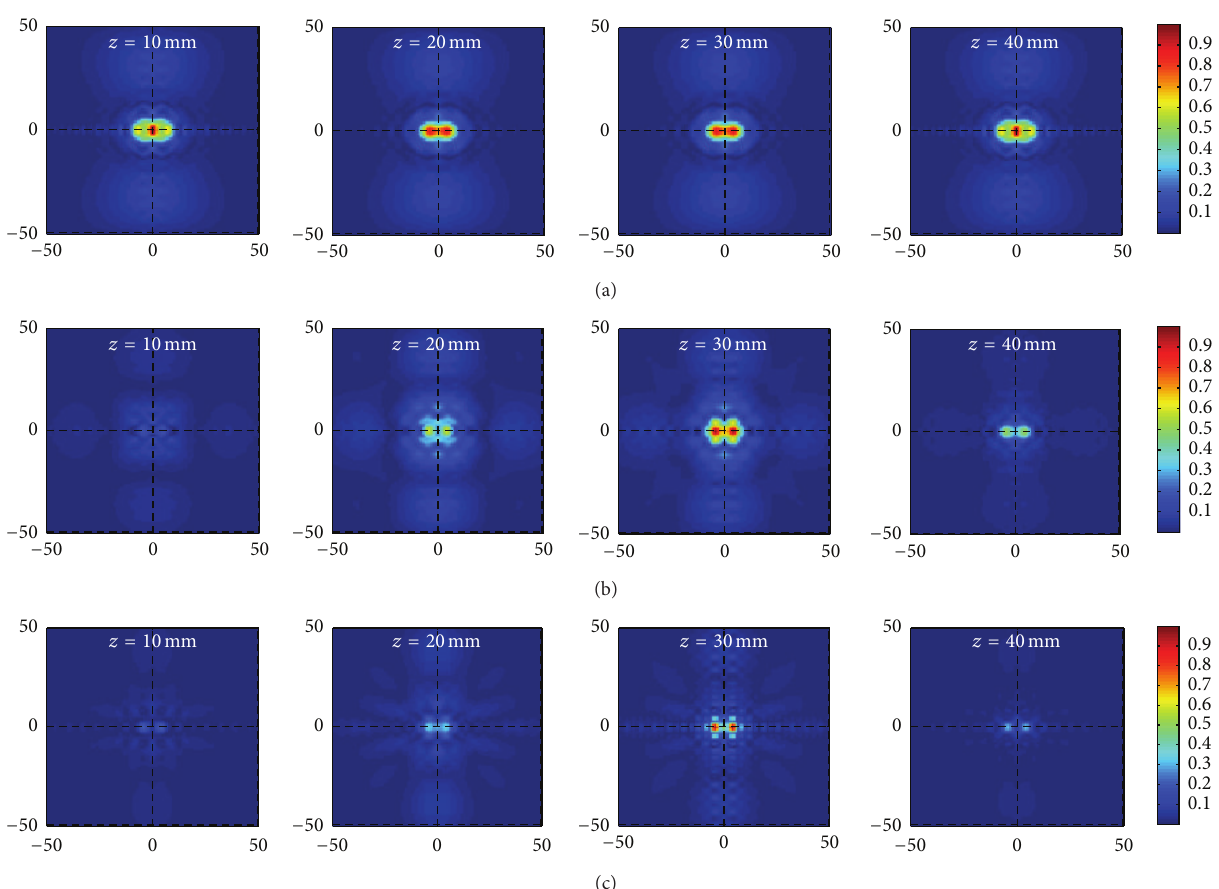
Figure 5: Reconstructed images for the objects shown in Figure 4 when applying 3D microwave holography to (a) only 𝑆 21 , (b) all five transmission 𝑆 -parameters when 𝐷 𝑥 = 𝐷 𝑦 = 10 mm, and (c) all five transmission 𝑆 -parameters when 𝐷 𝑥 = 𝐷 𝑦 = 20 mm. The horizontal and vertical axes show the positions along the 𝑥 and 𝑦 directions in terms of